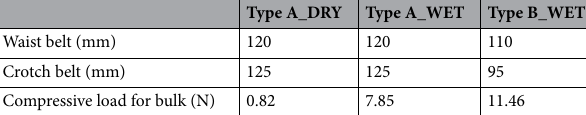
Table 1. Specifications of each diaper.